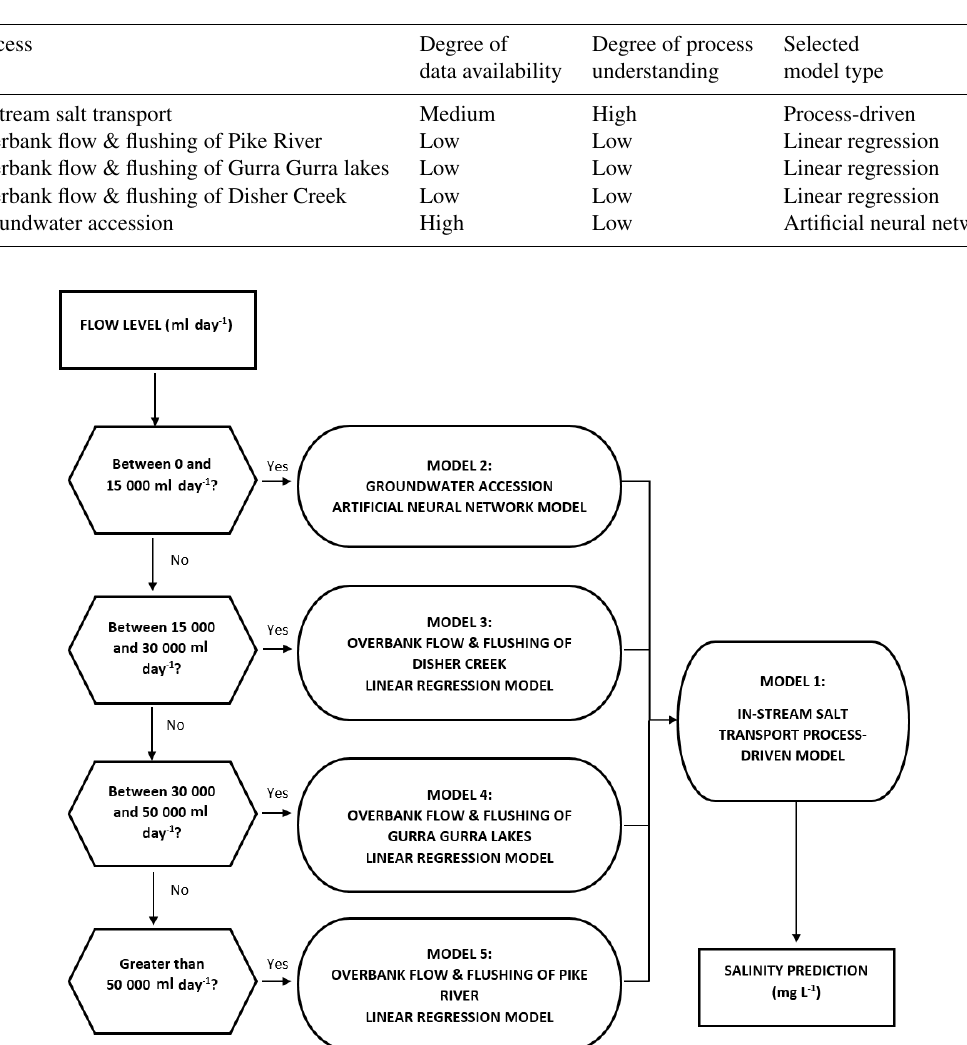
Table 2. Identified processes and the degree of data and understanding that are available for each.